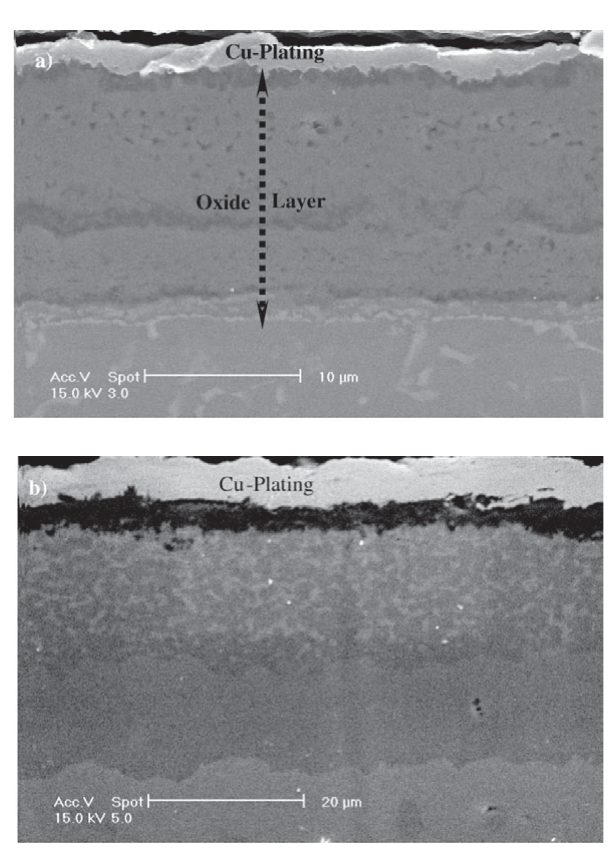
Figure 8 . Oxidation of coated and uncoated Ti aluminide coating